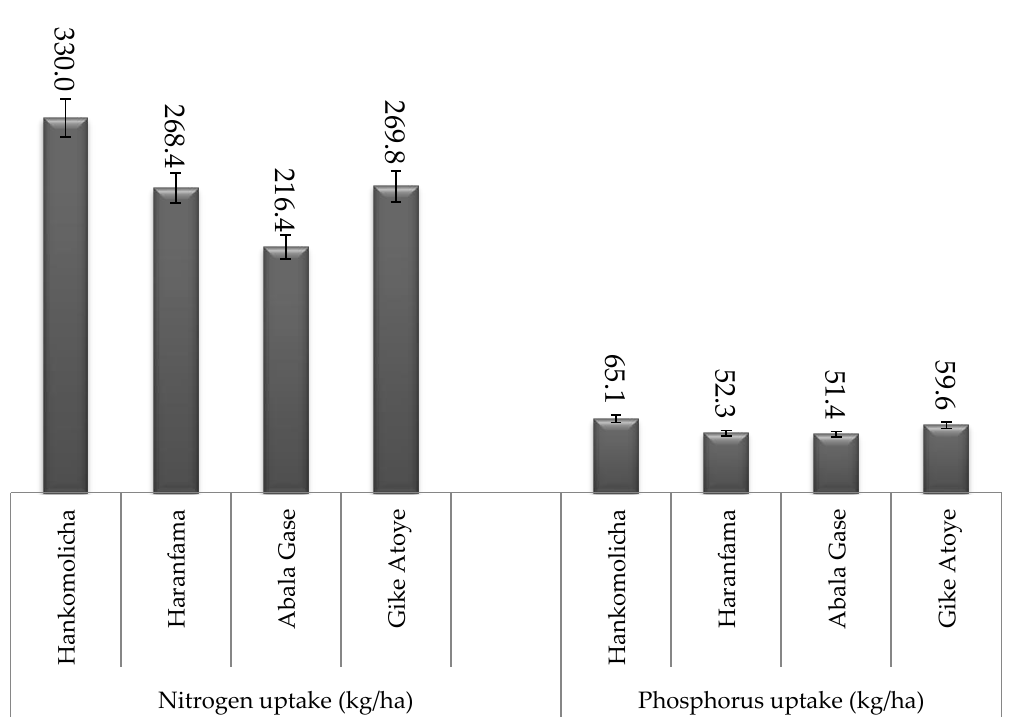
Figure 2. Nitrogen and phosphorus uptake of faba bean at the study locations.